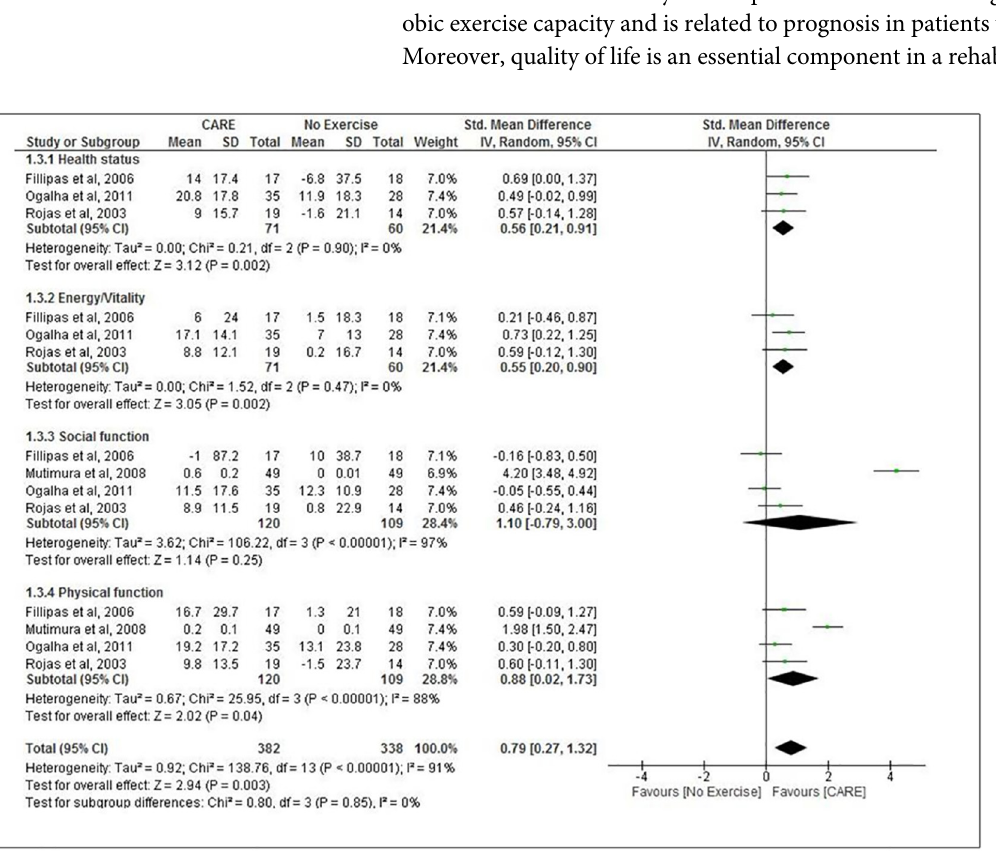
Fig 4. Combined aerobic and resistance exercise (CARE) versus No Exercise: HRQoL. Review Manager (RevMan). Version 5.2 The Cochrane Collaboration, 2013.